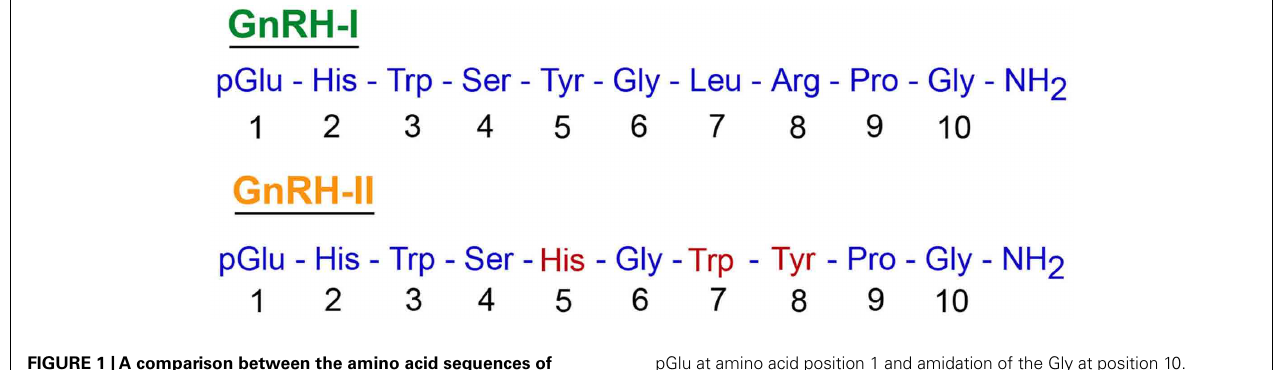
FIGURE 1 |A comparison between the amino acid sequences of GnRH-I and GnRH-II. Both decapeptides undergo similar post-translational modification, which includes conversion of Gln to